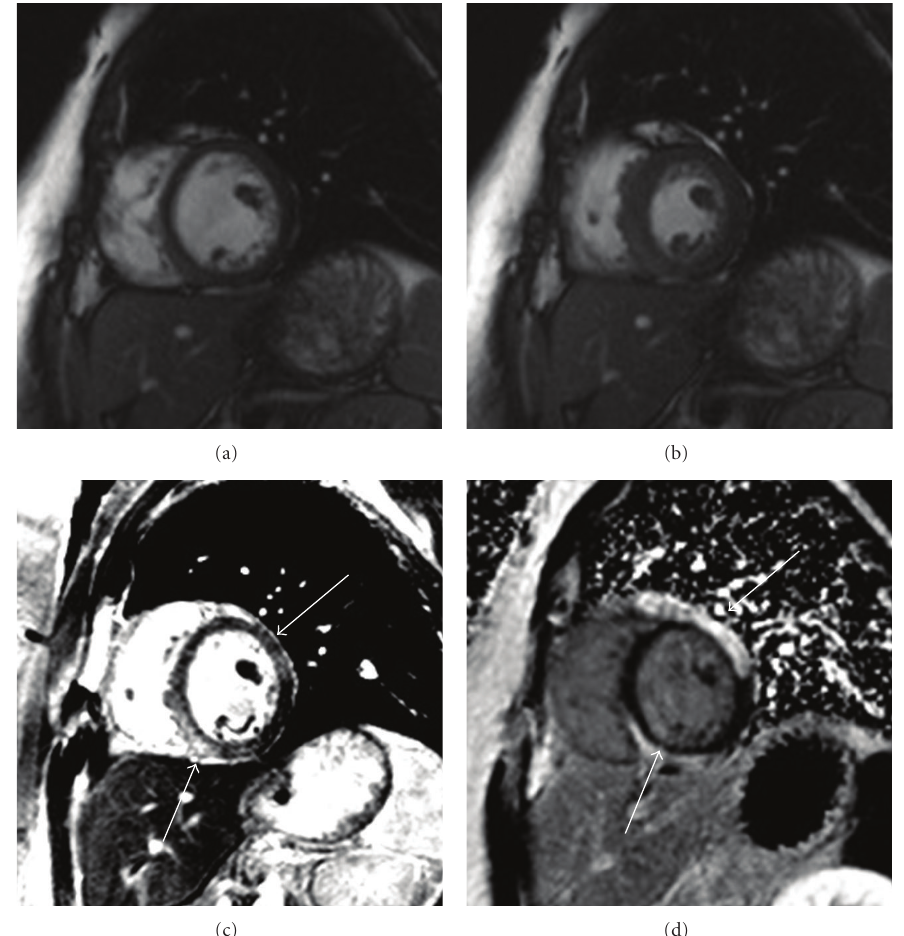
Figure 4: Myocardial infarction with normal coronary arteries. Images from a patient presenting with chest pain, elevated troponin but normal coronary arteries. Cine-SSFP images at (a) diastole and (b) systole demonstrate a wall motion abnormality in the inferoseptum and anterolateral walls. T 2 weighted imaging (c) shows focal areas of edema in these regions. (d) LGE imaging demonstrates epicardial-delayed enhancement. These findings are consistent with the diagnosis of